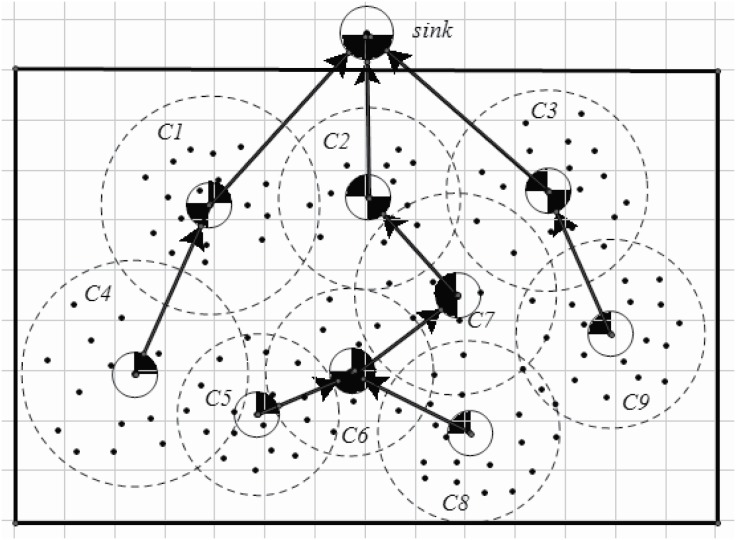
Directional virtual backboard construction.